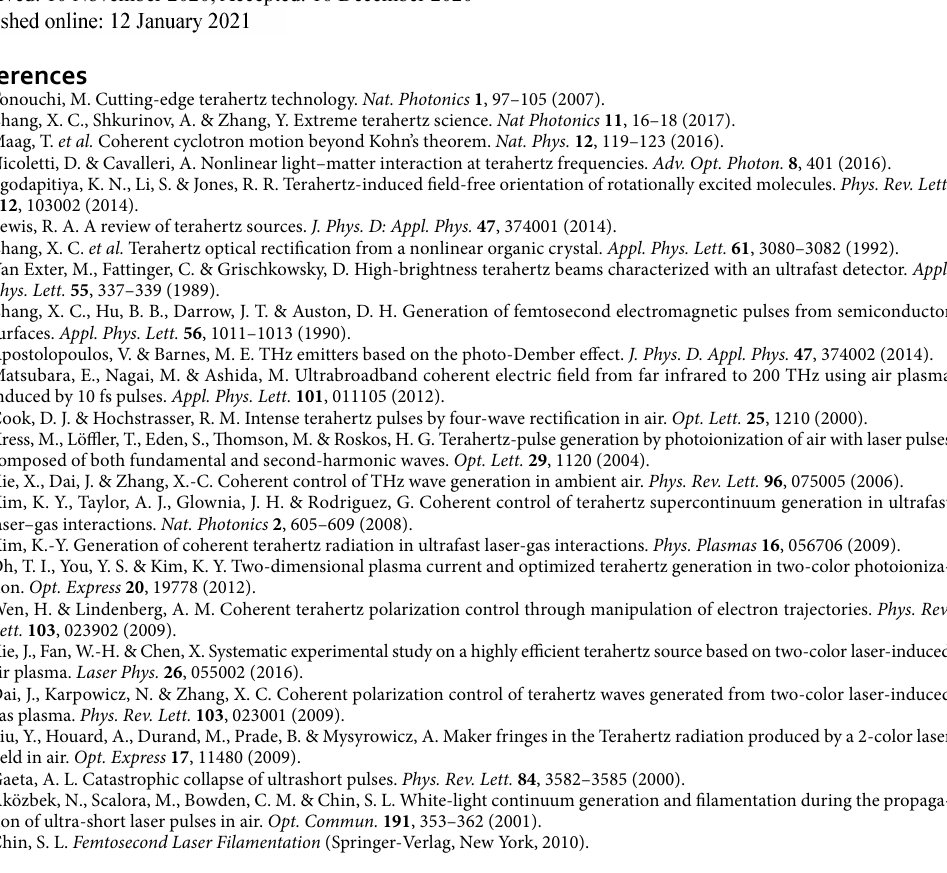
Fig. 5. The ratio of the two polarization intensity extremes is consistent with Eq. (10), which further verifies the accuracy of the fitting. Discussion on the cubic